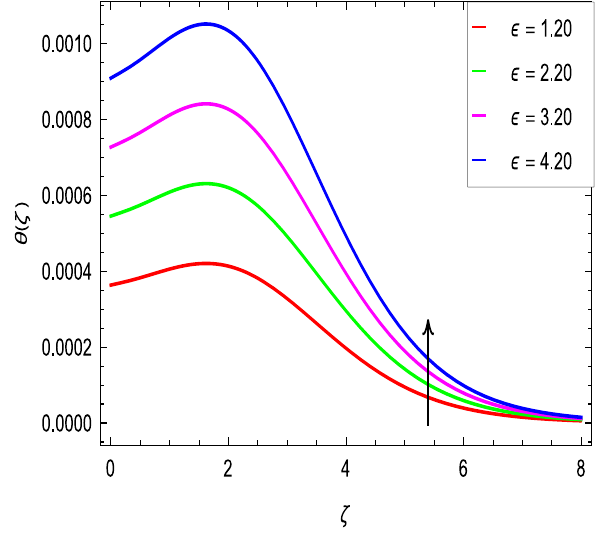
Figure 12. θ(ζ) in terms of ε .